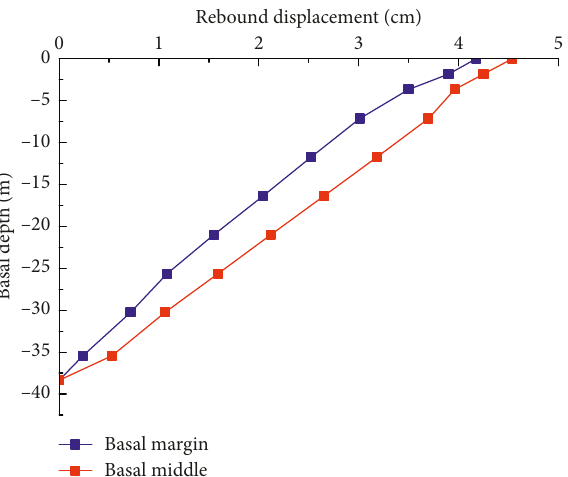
Figure 15: Rebound displacement along the depth distribution.